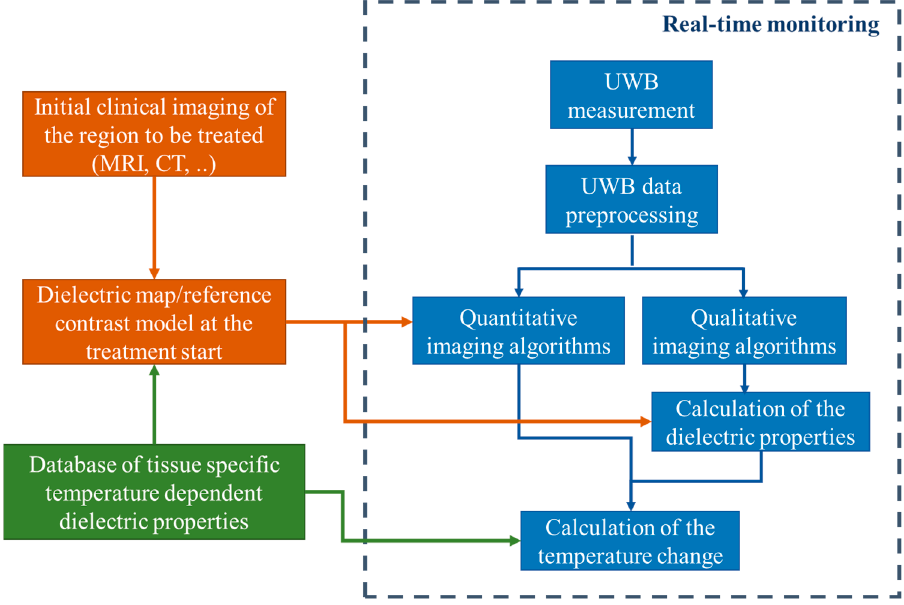
Figure 1. Flowchart of the tissue temperature monitoring methodology.